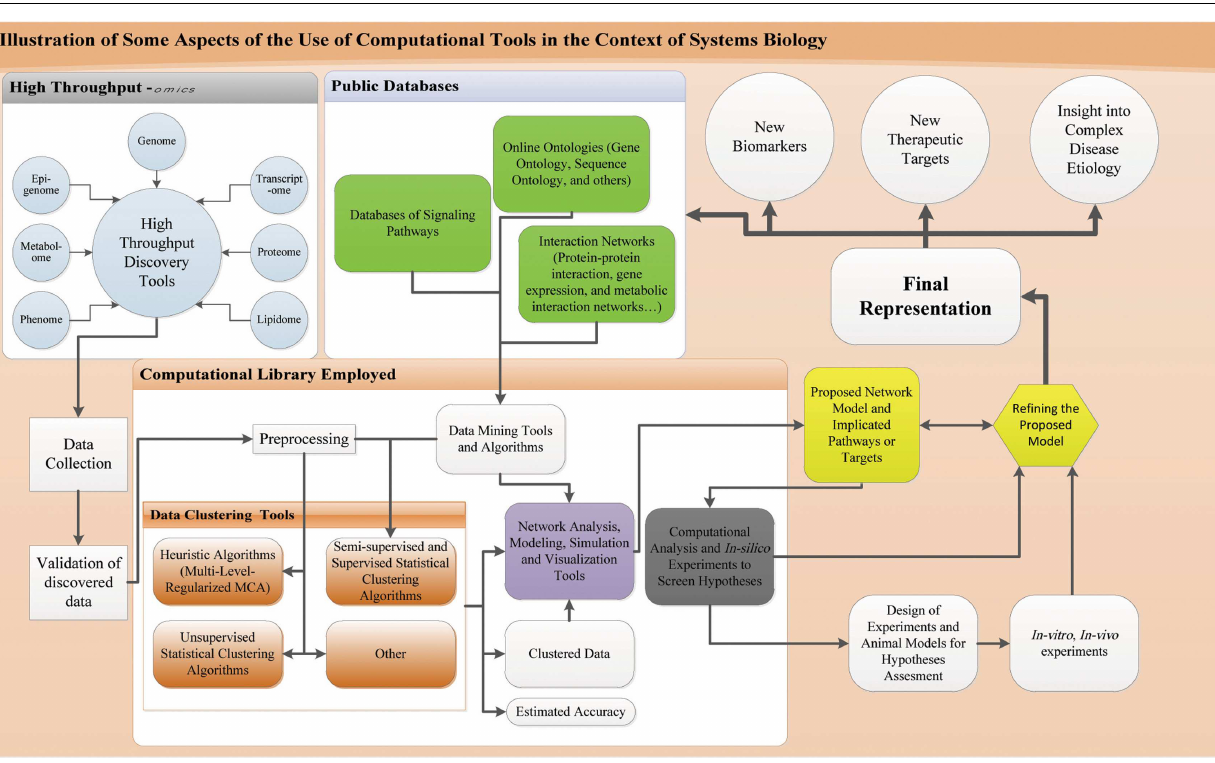
FIGURE 2 | Computational tools in the context of systems biology. Process of systems biology starting from the HT-discovery tools till biomarker discovery and elucidation of biological network: results of HT-discover tools are collected and appropriate validation procedure is run like western blot. Data is then subjected to computational analysis, preprocessed to fit into the different algorithms for clustering and classification.These algorithms include supervised, semi-supervised, and unsupervised statistical and heuristic algorithms along others. Knowledge based and supervised/semi-supervised algorithms have information feeding from public databases that include ontologies, signaling, and interaction networks. Information from these databases are obtained through appropriate data mining tools and software and fed into the algorithms.These algorithms will give clustered data with an estimated accuracy.This clustered data is imported to network analysis, modeling, simulation, and visualization tools.These tools get also information from